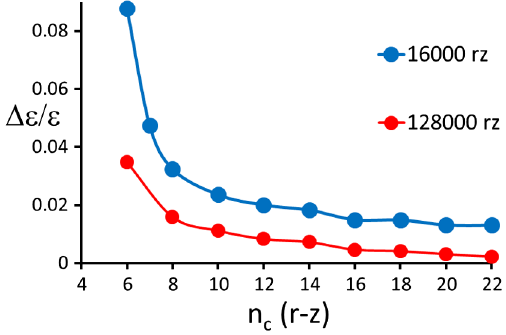
FIG. 6. Relative growth of ϵ 6 d for N ¼ 16 . 000 = 128 . 000 and increasing number of grid cells in r; z indicating transition from a grid resolution limited region to a collision dominated region